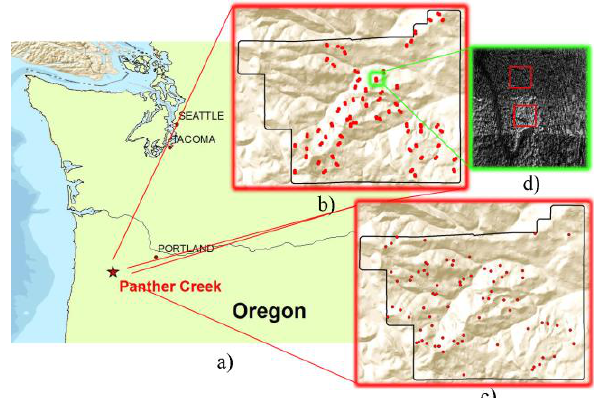
Figure 1. Study area: ( a ) location, ( b ) paired samples location, ( c ) field data plot locations, and ( d ) example of paired sample polygons with different point densities due to overlapping